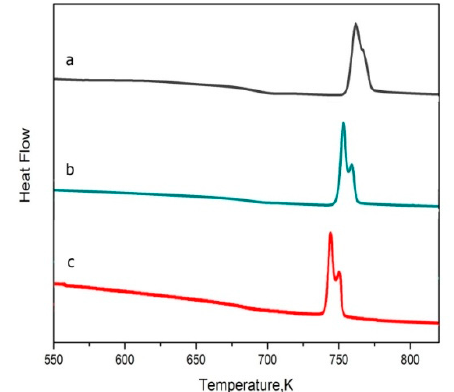
Figure 2. Di ff erential scanning calorimetry (DSC) curves of Zr 55 Cu 30 Al 10 Ni 5 alloy heated to 848 K at a constant rate of 5 ( a ), 10 ( b ) and 20 ( c ) K / min. Table 1. Crystallization temperatures for di ff erent heating rates. Heating Rate β , K / min Temperature of Crystallization Start T s ,